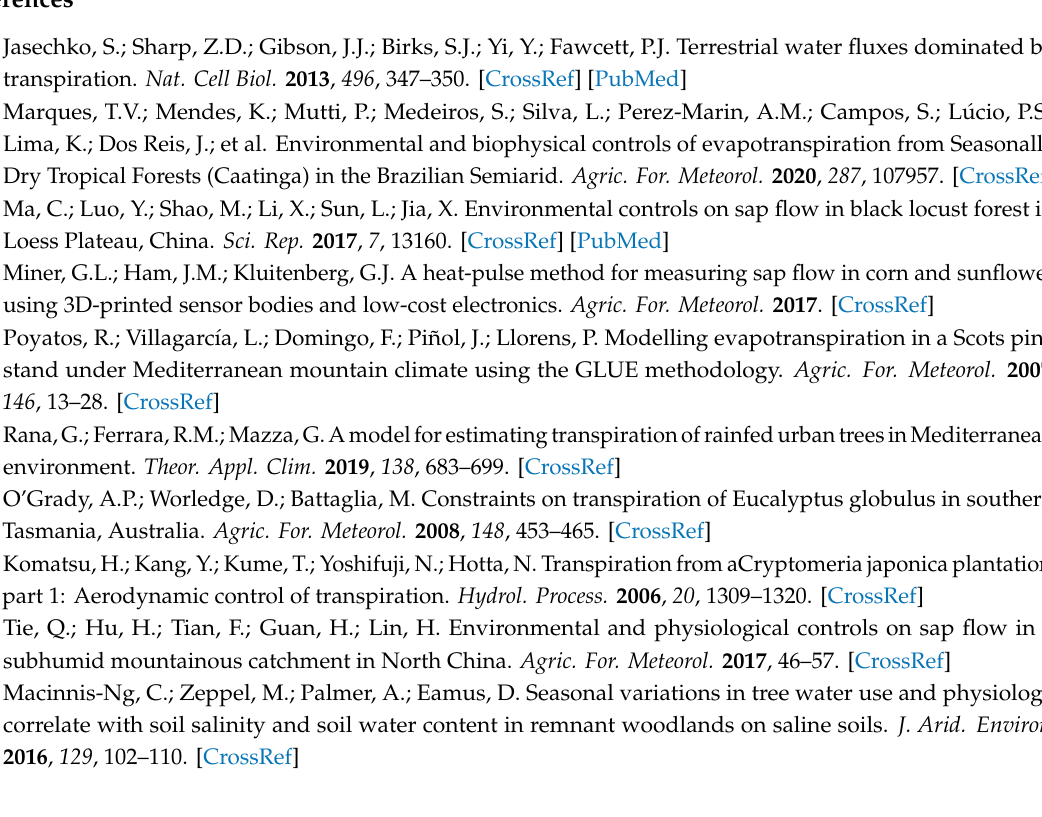
Figure S1: A schematic diagram of the greenhouse structure with experimental layout., Figure S2: Diurnal changes in photosynthetic rate (a), transpiration rate (b) and stomatal conductance (c) in di ff erent months in 2018. Note that these variables were measured using the LI-6400XT portable photosynthetic system (Li-Cor, Lincoln, Nebraska, USA) every 2 h on a sunny day per month during June to October, 2018. From plants with sap flow measurements, a total of 8 leaves were randomly marked for these